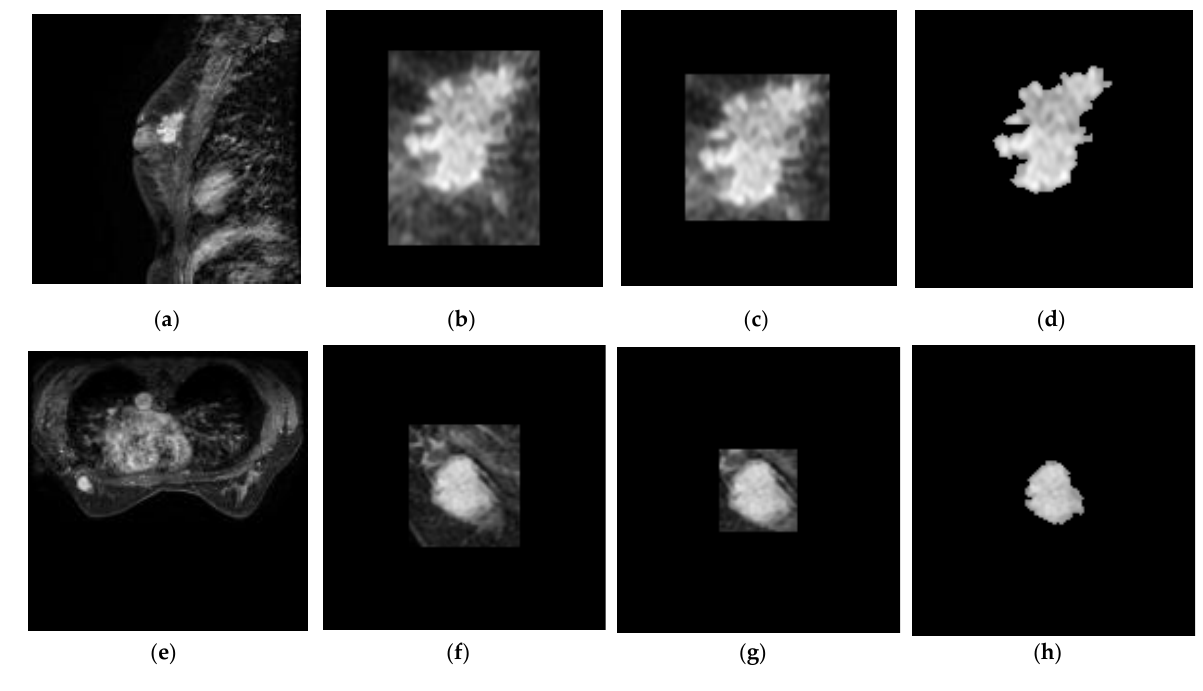
Figure 2. The flow of the SBBS-ROI extraction. * represents multiplication operation.